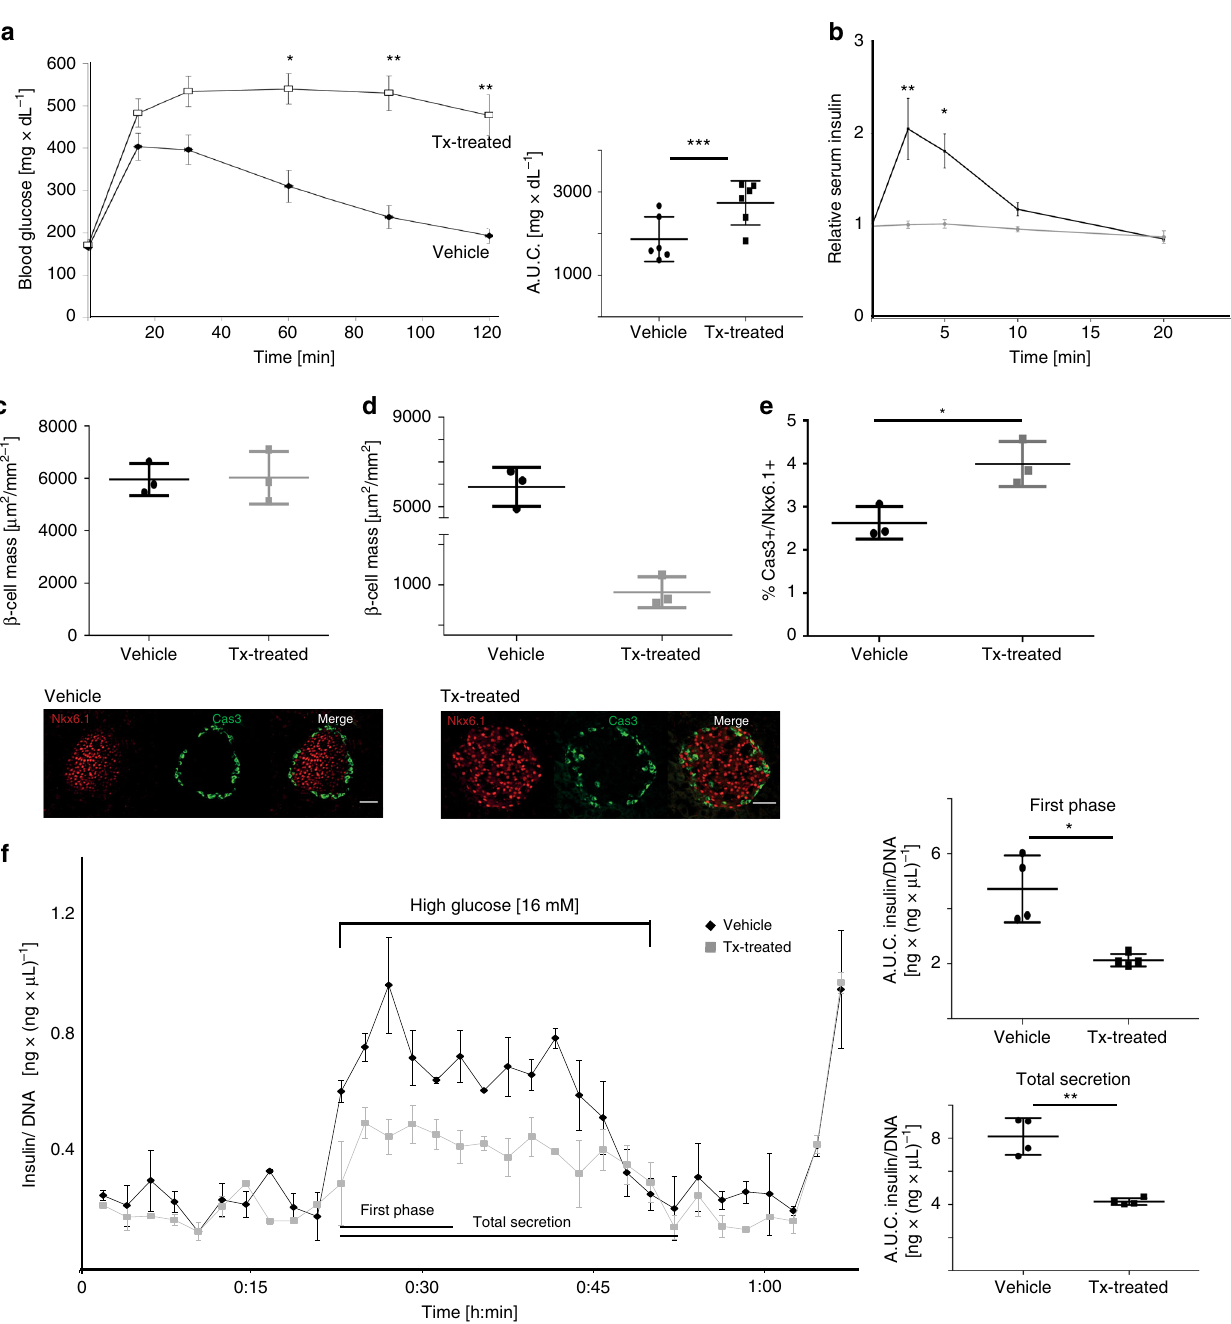
Fig. 1 Characterization of β ICKO mice phenotype. a Intraperitoneal glucose tolerance test at 12 week post induction ( n = 6, p < 0.0001 (GTT, repeated measures one-way ANOVA); p = 0.002 (AUC, one-way ANOVA, Holm-Sidak multiple comparison) mean ± s.e.m.). b Insulin-secretion test. ( n = 3, p < 0.0001 (GTT, repeated measures one-way ANOVA), mean ± s.e.m.) 12 weeks post induction. c β -cell mass 6 weeks post induction ( n = 3, mean ± s.d.). d β -cell mass 20 weeks post induction ( n = 3, p = 0.0006 ( t test), mean ± s.d.). e Percentage of apoptotic beta cells over total of beta cells. Representative images of control and treated animal islets. Nkx6.1 shown in red, and caspase-3 in green ( n = 3 animals, n = 10 islet per animal, 20 weeks post induction, scale bar 50 µ m, p = 0.0216, mean ± s.d.). f Dynamic insulin secretion of isolated β ICKO islets (Tx-treated shown in gray, veh shown in black). AUC ( t test), islets pooled from n = 10 animals, experiment repeated n = 4, and insulin measured n = 2 per experiment, mean ±